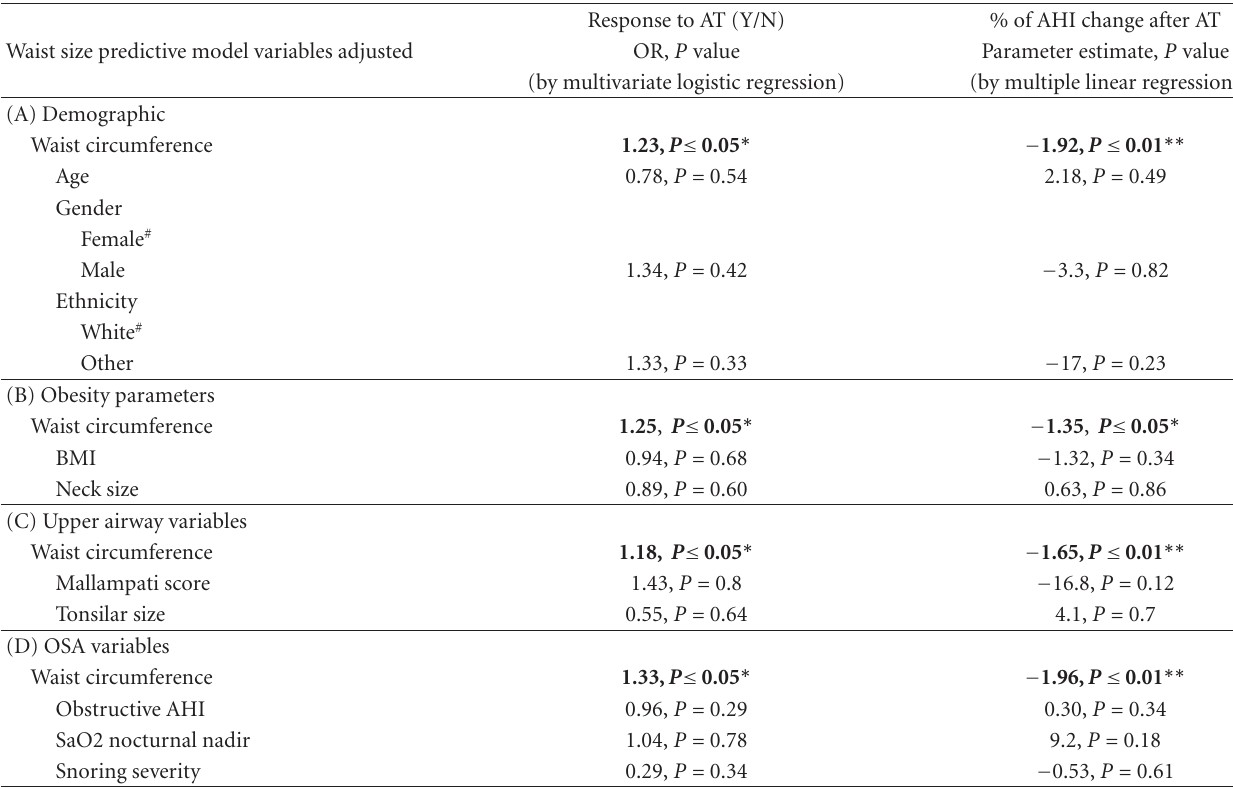
Table 3: Multivariate regression analysis. Either regular linear regression or binary logistic regression was performed, depending on the type of outcome variable in the statistical model. For logistic regression, the odds ratios (OR) and their P values are reported; while for regular linear regression, the parameter estimates and their P values are